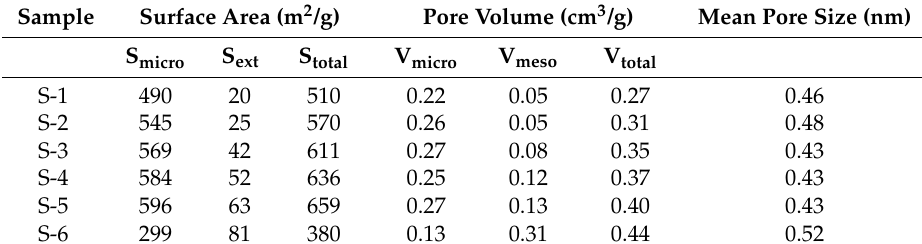
Table 1. The structural properties and surface compositions of the catalysts.